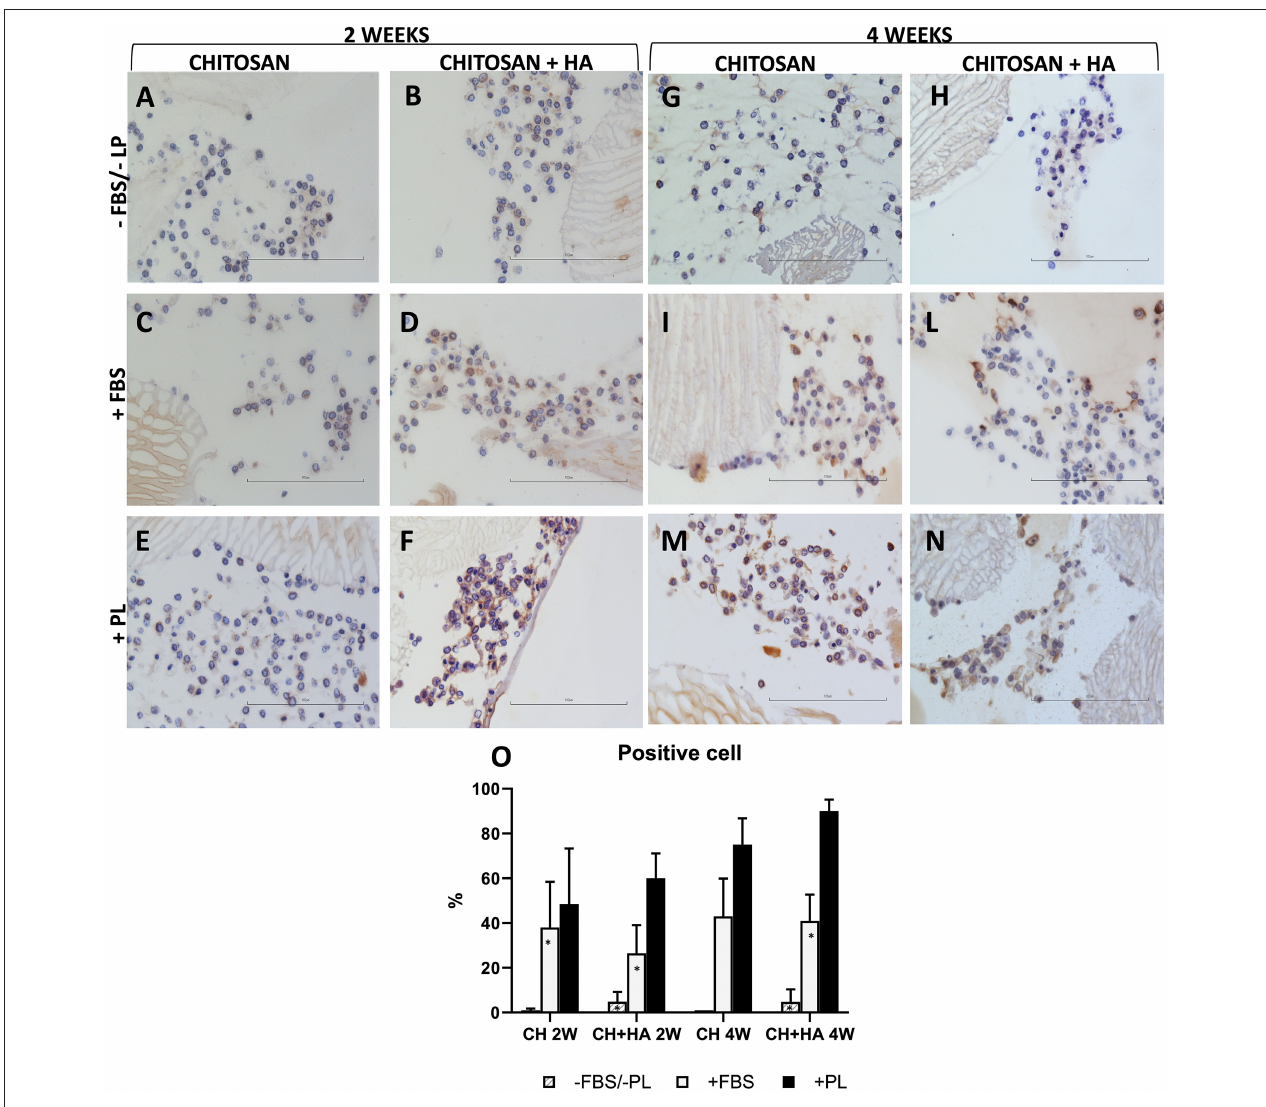
FIGURE 5 | Immunohistochemical stain for collagen type II in chitosan scaffolds (A,C,E,G,I,M) and chitosan scaffolds prepared with hyaluronic acid (HA) (B,D,F,H,L,N) with chondrocytes cultured in different conditions after 2 and 4 weeks. –FBS/–PL (A,B,G,H) ; + FBS (C,D,I,L) ; + PL (E,F,M,N) . Scale bar = 100 µ m. (O) Quantification of Collagen type II expressed as percentage of positive cell. Statistical analysis: asterisk indicate significant differences versus PL (* P < 0.05, n =